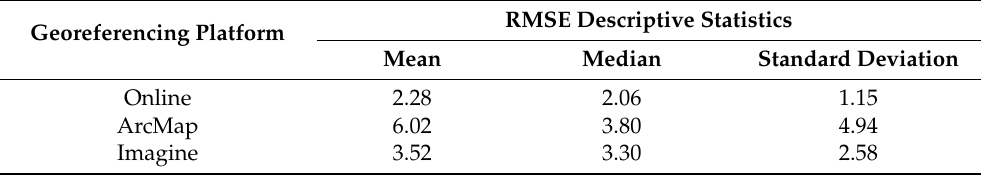
Table 3. The Wilcoxon Signed Rank Test Null Hypothesis and Result (* denotes significant at the 0.05 level). Paired Group Null Hypothesis p -Value The median difference between the two sets of RMSE Online vs. ArcMap (Online, ArcMap) is zero at a significance level of 0.05 The median difference between the two sets of RMSE Online vs. Imagine (Online, Imagine) is zero at a significance level of 0.05 The median difference between the two sets of RMSE ArcMap vs. Imagine (ArcMap, Imagine) is zero at a significance level of 0.05